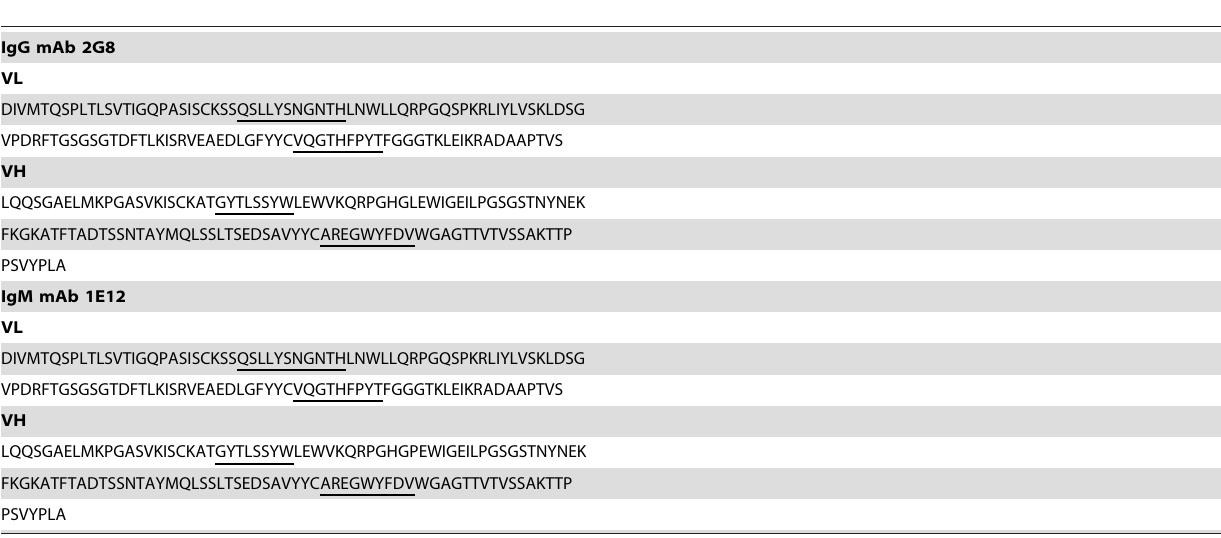
Table 1. Deduced amino acid sequences of the variable regions of the light (VL) and heavy (VH) chains of IgG mAb 2G8 and IgM mAb 1E12 showing their complete